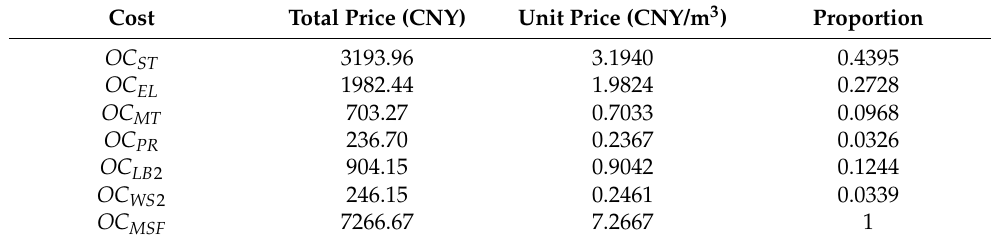
Table 21. OT-MSF system cost ratio table.